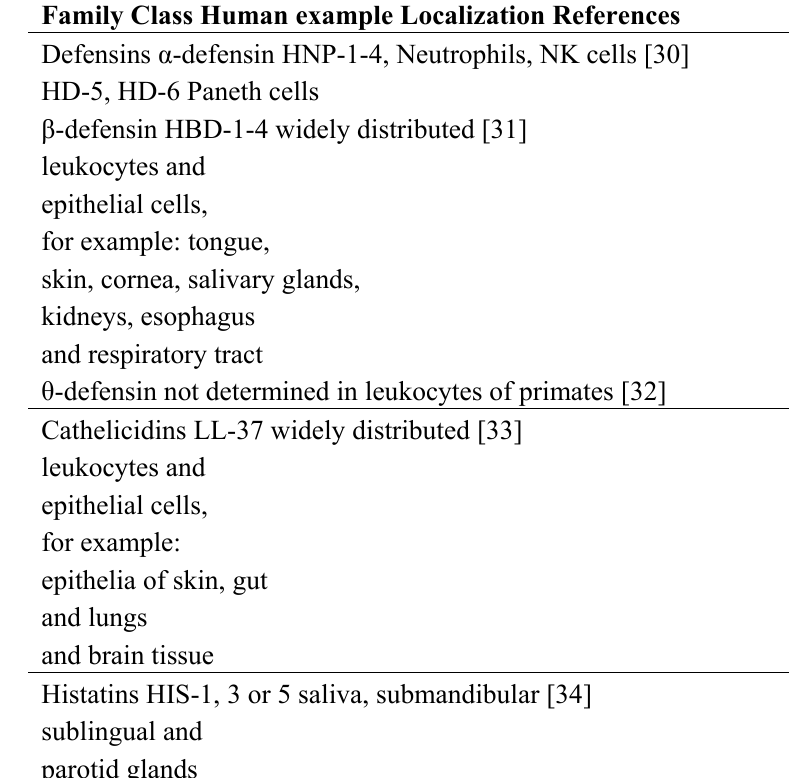
Table 1. Main human AP families and their